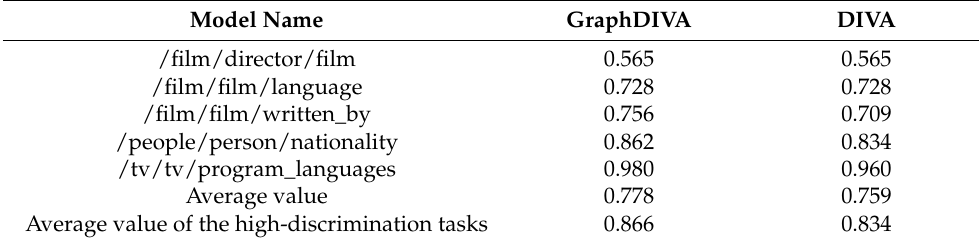
Table 4. FB15K-237 test results.